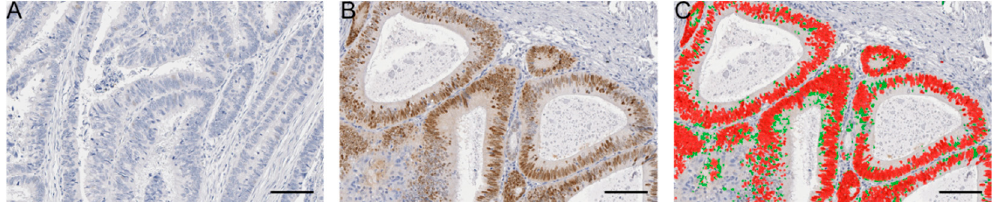
Figure 1. SOX2 (sex-determining region-Y homeobox-2) staining and quantification. Representative images of ( A ) SOX2 low and ( B ) high immunostaining and ( C ) digital analysis of the SOX2 high sample using StrataQuest software. Scale bars 100 μ m.